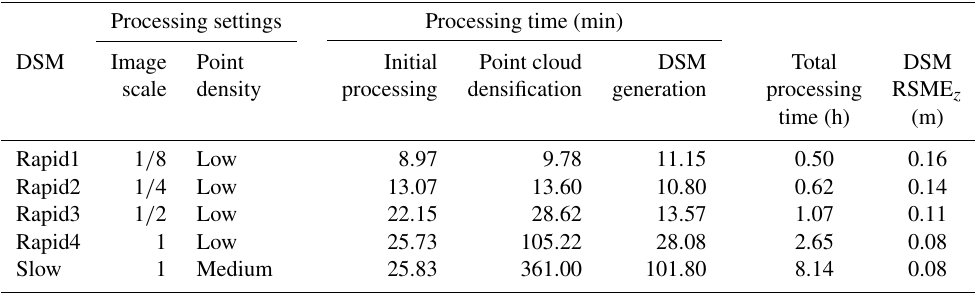
Table 1. DSMs generated with different processing settings in Pix4D (v4.3.27), with processing time (minutes) for each step, the total processing time (hours), and the resulting RMSE z . The processing was done using a high-performance computer (an Intel ® Core ™ i9- 7900X CPU at 3.30GHz with 64GB RAM and an NVIDIA GeForce GTX 1080 GPU).